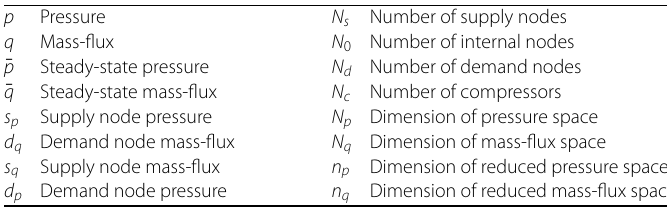
Table 1 List of recurring